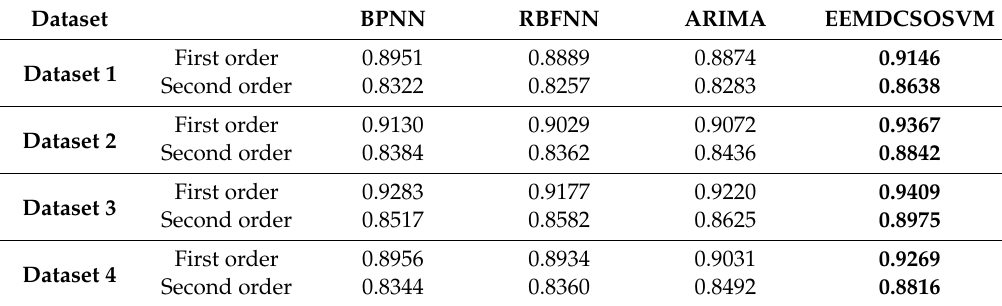
Table 9. Forecasting Effectiveness of different models for four